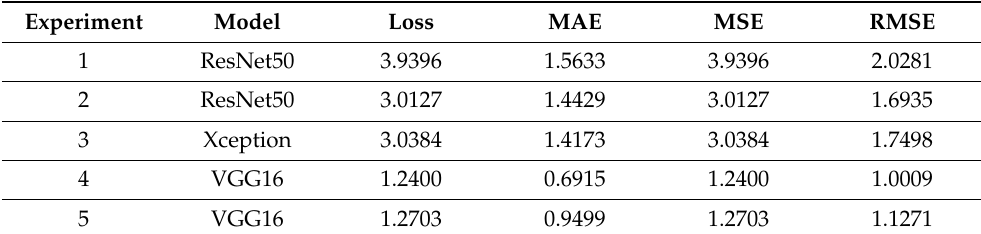
Figure 8. Error rate of VGG16 through the epochs. Experiment 5 tested images for age nine. The dataset consisted of 90 images, 72 images for training and 18 images for testing. The VGG16 model produced the lowest error rate (0.6915). Figure 8 shows the error rate of VGG16 through the epochs. Model performance was dependent on the age range as the data were imbalanced. Table 3. Summary of best results for each experiment.